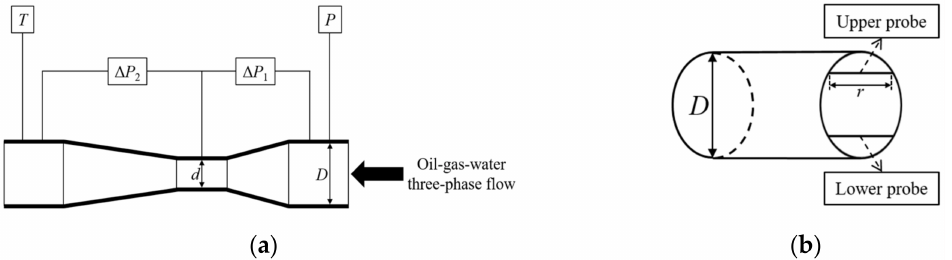
Figure 2. The schematic diagrams of the multiple sensors. ( a ) The structure diagram of the section installed with the temperature sensor, the pressure sensor and the Venturi tube; ( b ) The structure diagram of the microwave sensor.